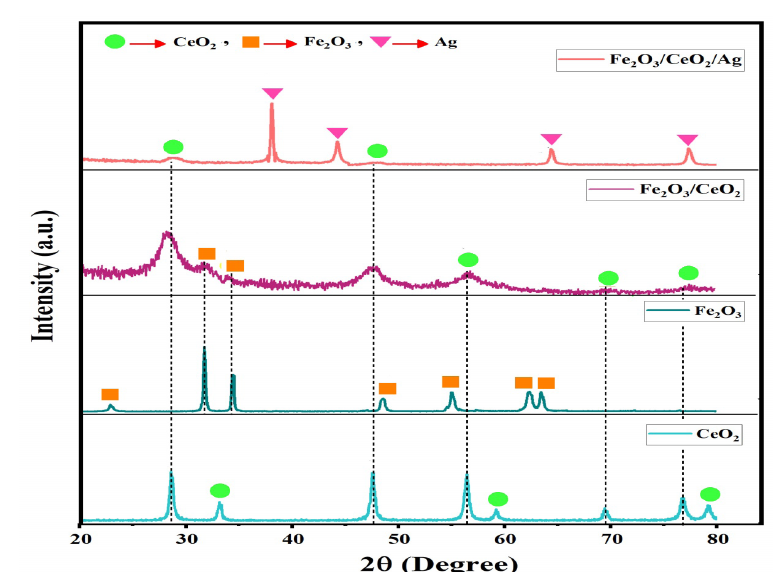
, Fe O , Fe O /CeO 2 2 3 2 3